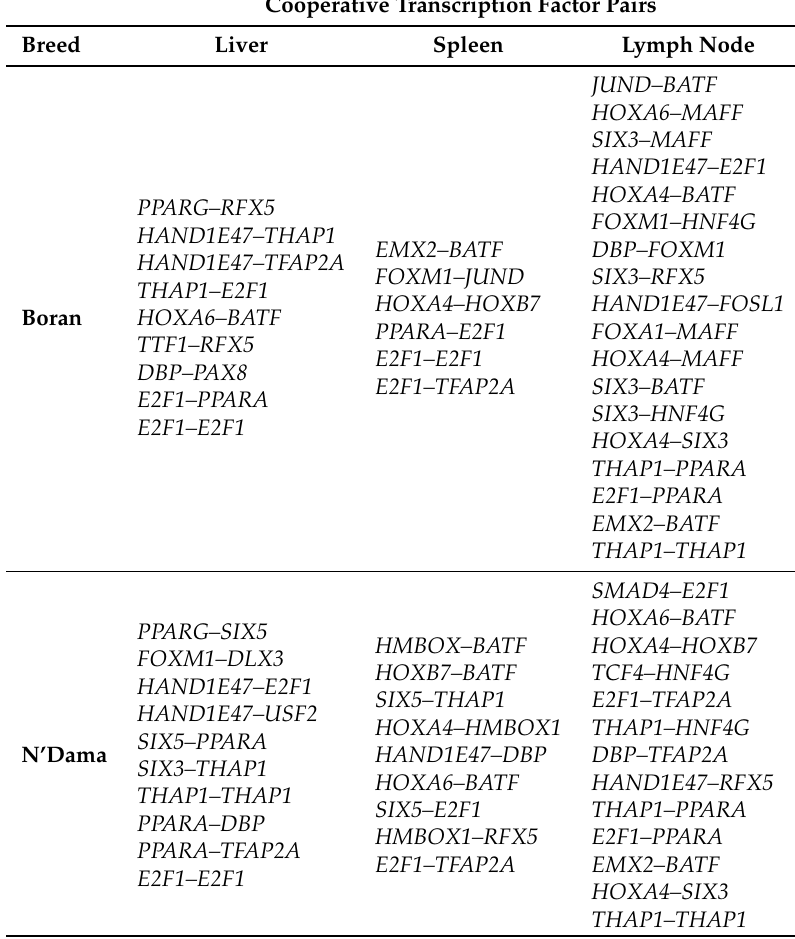
Table 2. Cooperative TF pairs specific for liver-, spleen-, and lymph node tissues of Boran and N’Dama obtained from PC-TraFF